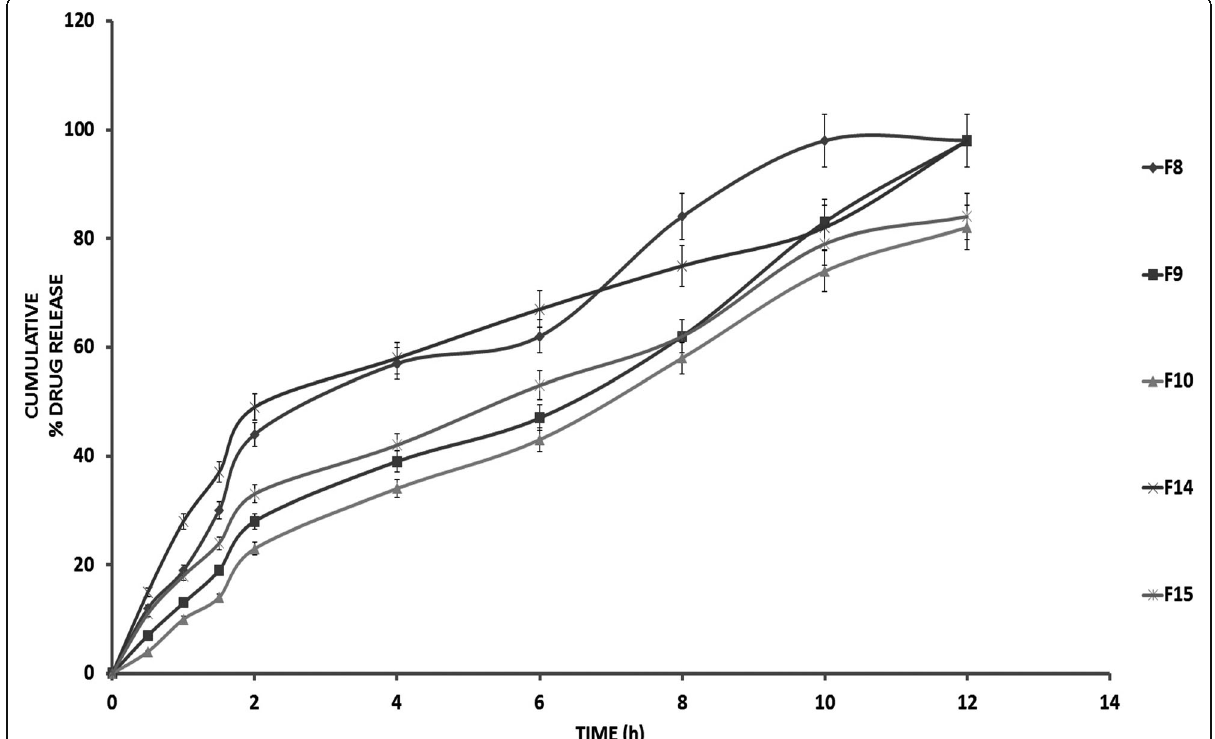
Fig. 2 Plot depicting the cumulative % drug release profile of formulation F8, F9, F10, F14 and